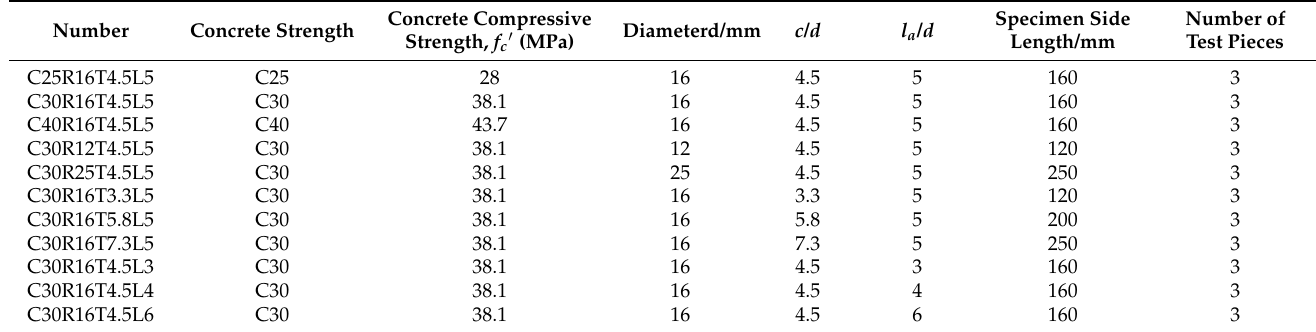
Table 8. Bonding test specimen grouping table.